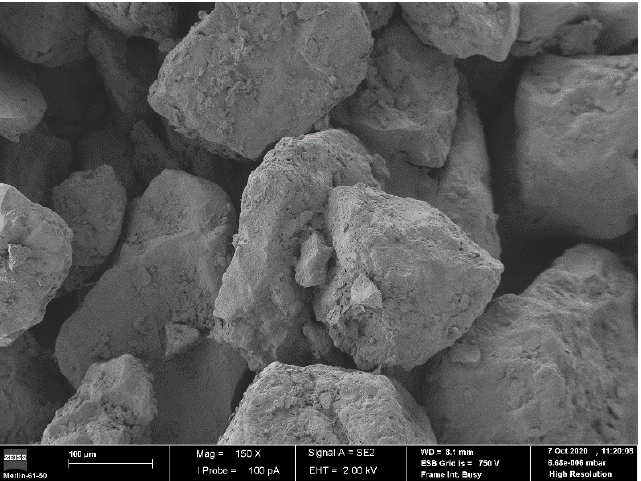
Figure 6. SEM image of the natural soil at 150×.